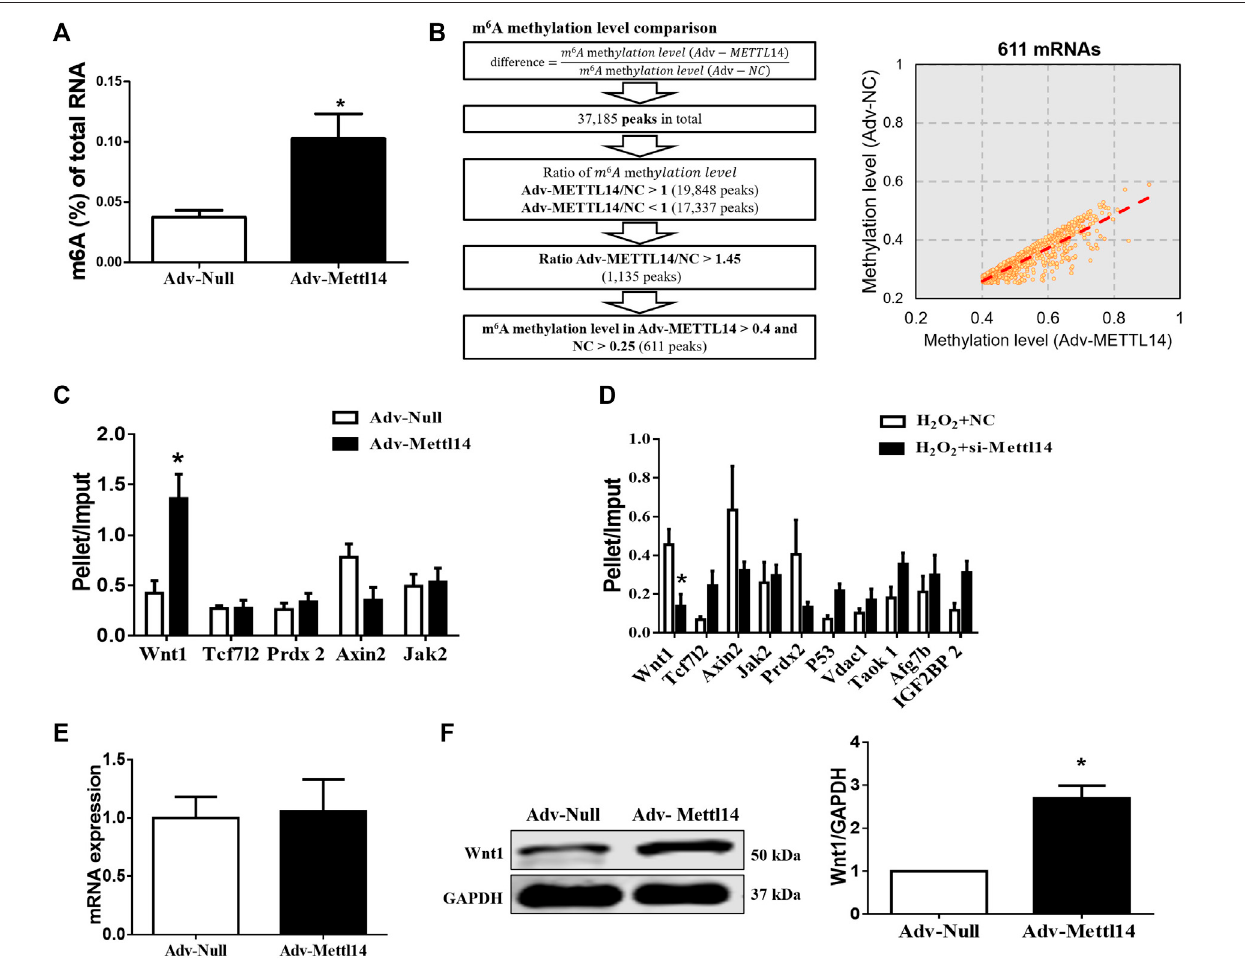
FIGURE 5 | Mettl14 activates the Wnt/ β -catenin signaling pathway in an m6A-dependent manner. (A) Enzyme-linked immunosorbent assay (ELISA) detects the level of m6A modi fi cation of RNA in cardiomyocytes treated with adenovirus. Adv-Null n (cid:2) 4, Adv-Mettl14 n (cid:2) 5. * p < 0.05 versus Adv-Null. (B) Schematic for microarray sample collection with two groups: NC, Adv-Mettl14 in cardiomyocytes, indicating 37185 genes ’ different expression. n (cid:2) 1. (C , D) m6A-immunoprecipitation (RIP) microarrayexaminedthem6AlevelofmRNAscausedbyMettl14overexpression (C) andsilencewithH 2 O 2 (D) ,respectively. n (cid:2) 4fromthreeindependentcultures. * p < 0.05versusAdv-Null. n (cid:2) 3fromthreeindependentcultures.* p < 0.05versusH 2 O 2 +NC. (E) CardiomyocyteswereinfectedwithMettl14expressionvectororempty vector. The Wnt1 mRNA level was analyzed by qRT-PCR. Adv-Null n (cid:2) 4, Adv-Mettl14 n (cid:2) 6. * p > 0.05 versus Adv-Null. (F) Wnt1 protein level in cardiomyocytes was analyzed by Western blotting. n (cid:2) 3 from three independent cultures. * p < 0.05 versus Adv-Null. Data are represented as mean ± SEM.